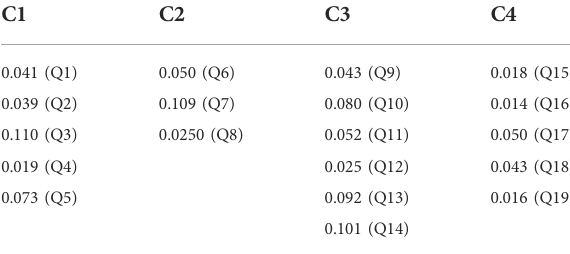
TABLE 6 Weighting result of combination weighting method.